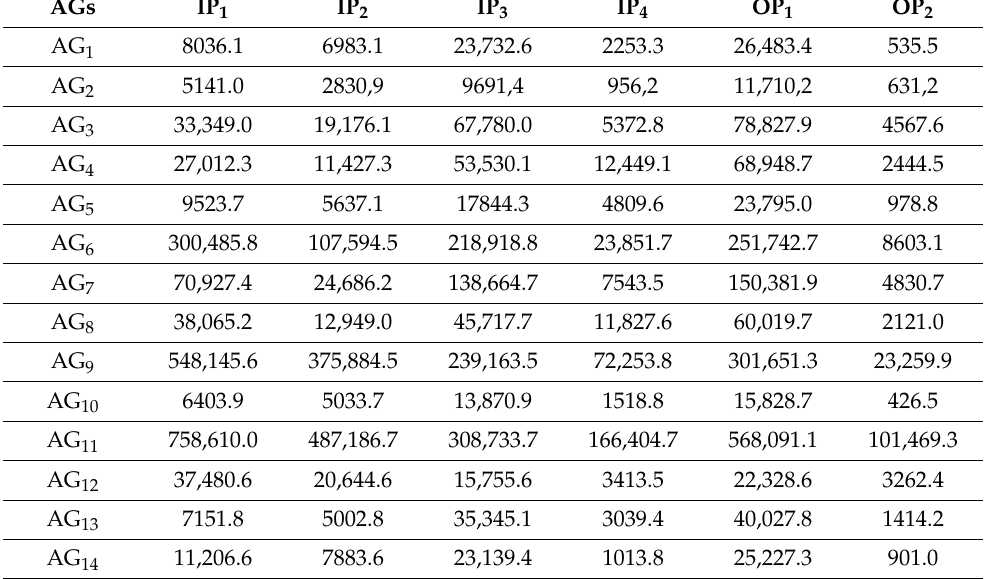
Table 5. Data in 2017 (Unit: 1000